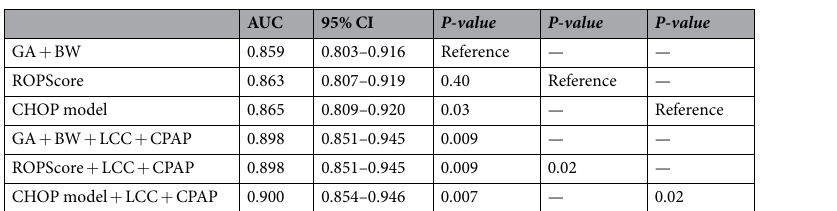
Table 6. AUCs for prediction of TR-ROP from infants with any degree of ROP using combination of ROPScore, CHOP model and significant predictors. Abbreviations: AUC, area under receiver operating characteristic curve; ROP, retinopathy of prematurity; TR-ROP, treatment-requiring retinopathy of prematurity; CI, confidence interval; GA, gestational age; BW, birthweight; CHOP model, Children’s Hospital of